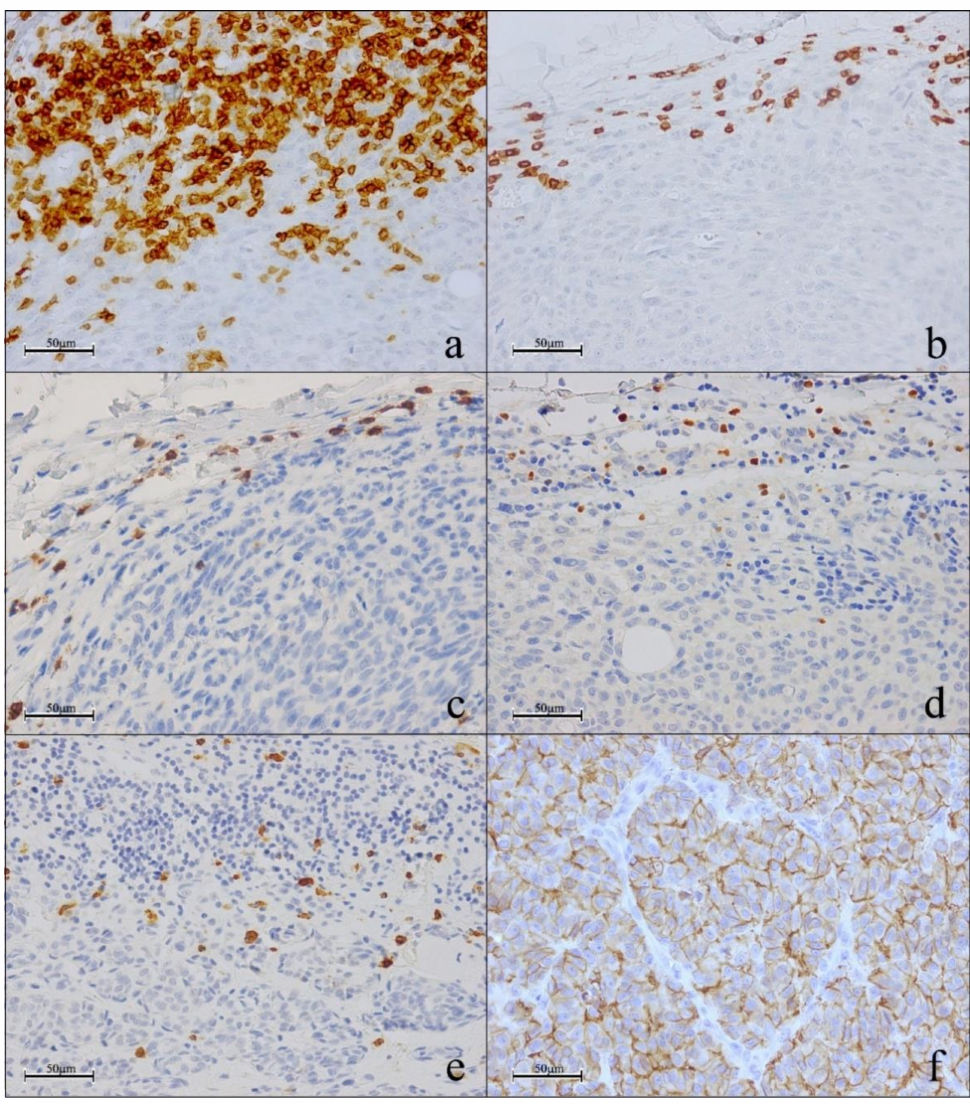
Figure 1. Single immunohistochemistry assay on peritumoral ( a – e ) or intratumoral ( f ) area of melanoma samples. Representative image of single immunostaining: expressions of high CD3 ( a ); low CD3 ( b ); CD8 ( c ); FOXP3 ( d ); GRZB ( e ); PD-L1 ( f ). PD-L1 + cancer cells showed membrane immune reactivity (Figure 1f). PD-L1 ex- pression was observed in 10/30 cases (33.3%) (range of PD-L1 expression 3–20%), of which 3/14 (21.4%) were primary melanomas and 7/16 (43.7%) were unmatched